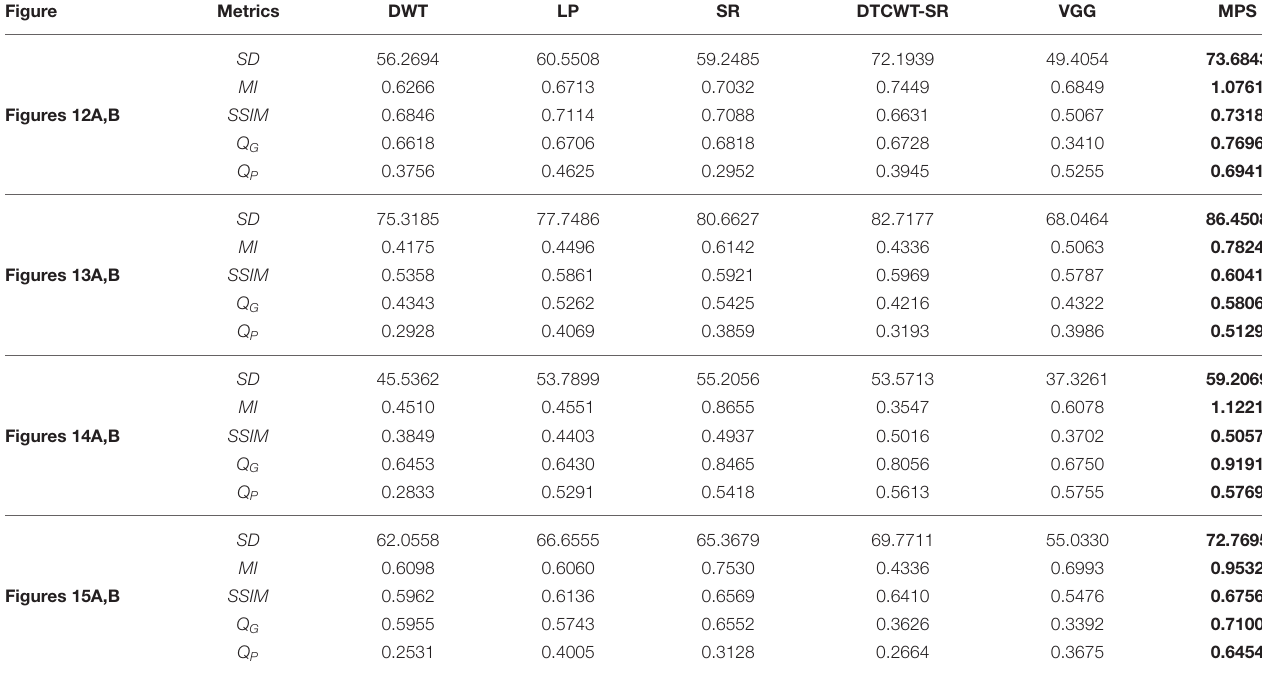
TABLE 5 | Comparison of objective evaluation metrics of CT and MRI images. Figure